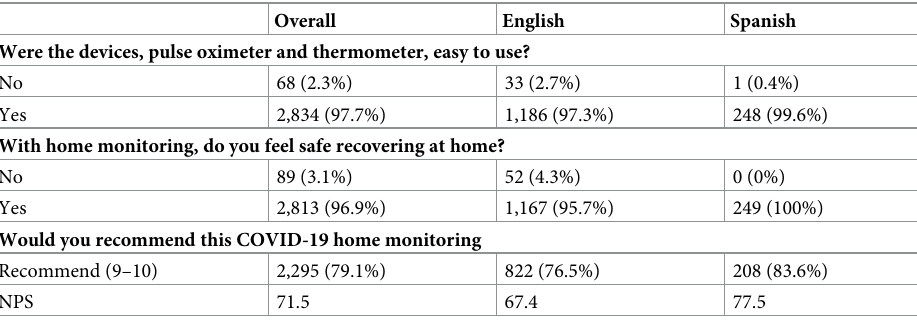
Table 3. Home monitoring program participant satisfaction. Overall English Spanish Were the devices, pulse oximeter and thermometer, easy to use? No 68 (2.3%) 33 (2.7%) 1 (0.4%) Yes 2,834 (97.7%) 1,186 (97.3%) 248 (99.6%) With home monitoring, do you feel safe recovering at home? No 89 (3.1%) 52 (4.3%) 0 (0%) Yes 2,813 (96.9%) 1,167 (95.7%) 249 (100%) Would you recommend this COVID-19 home monitoring Recommend (9–10) 2,295 (79.1%) 822 (76.5%) 208 (83.6%) NPS 71.5 67.4 77.5 Results of a satisfaction survey sent to participants in the HMP. The third item was rated on a scale of 1 (Very Unlikely) to 10 (Very Likely). NPS = net promoter